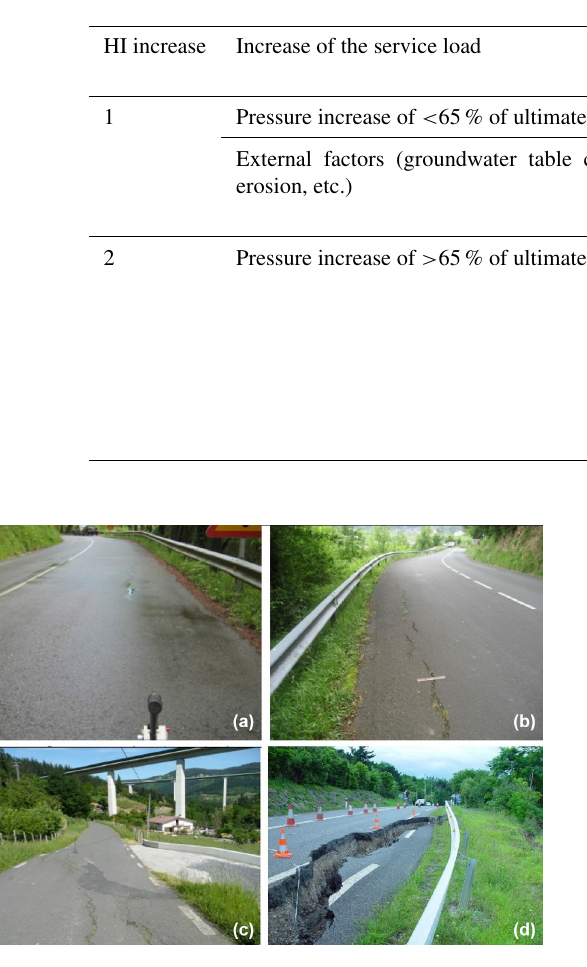
Figure 5. The four damage levels identified on the roads of Gipuzkoa: (a) no/slight damage, (b) moderate damage, (c) severe damage, and (d) partial/total